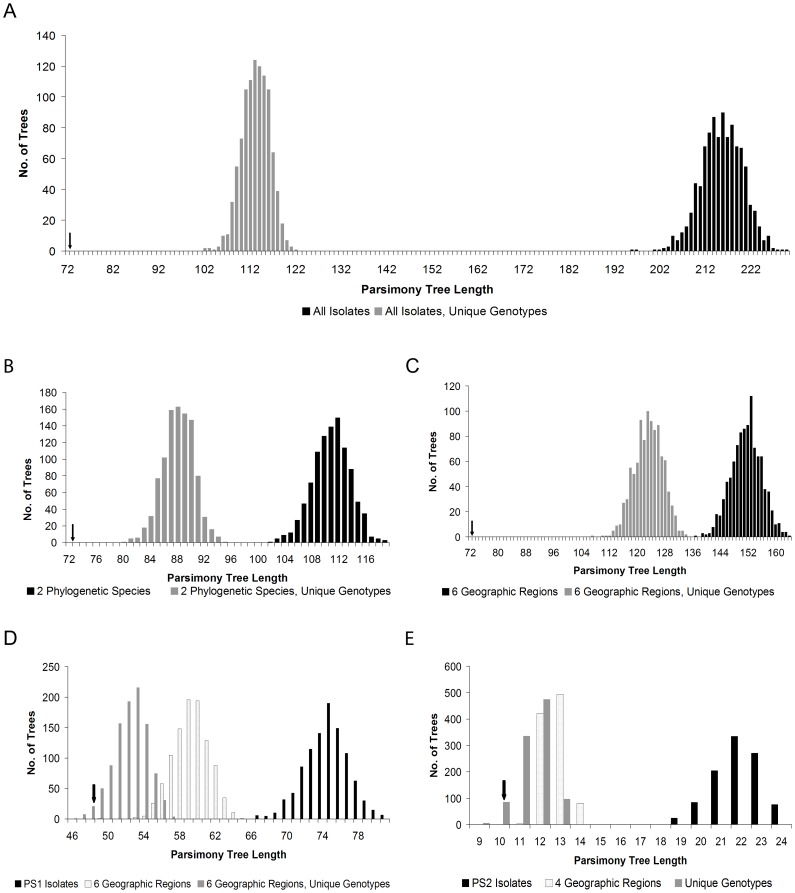
Parsimony Tree Permutation Length Test (PTPLT).A frequency distribution of tree lengths of maximum parsimony trees for 1000 artificially recombined datasets as compared to the observed tree length was calculated for: (a) All isolates in the B. dermatitidis population treated as a single population both with and without reduction to unique genotypes; (b) All isolates partitioned into two phylogenetic species (PS1) and (PS2) both with and without reduction to unique genotypes; (c) All isolates partitioned into 6 geographic regions both with and without reduction to unique genotypes; (d) Isolates of PS1 treated as a single population, partitioned into 6 geographic regions both with and without reduction to unique genotypes; (e) Isolates of PS2 treated as a single population, partitioned into 4 geographic regions, or reduced to unique genotypes (due to the low number of unique genotypes in PS2, we were unable to partition them by geographic region). Recombination was not detected between PS1 and PS2. Recombination was detected in PS1 (d) when partitioned by geographic region and reduced to unique genotypes and in PS2 (e) when reduced to unique genotypes.